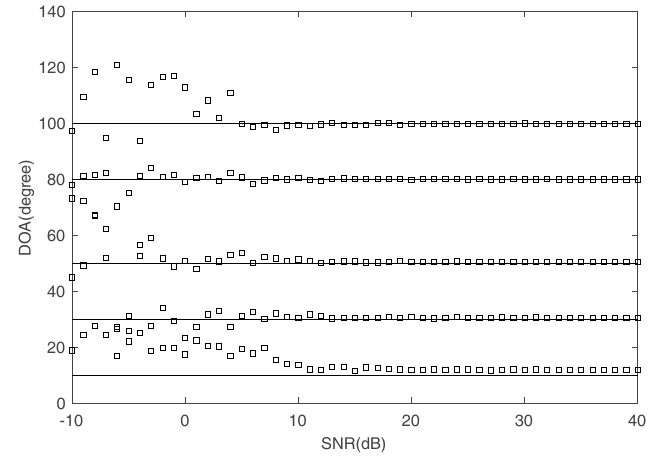
Figure 16. The comparison between the true and estimated DOA.